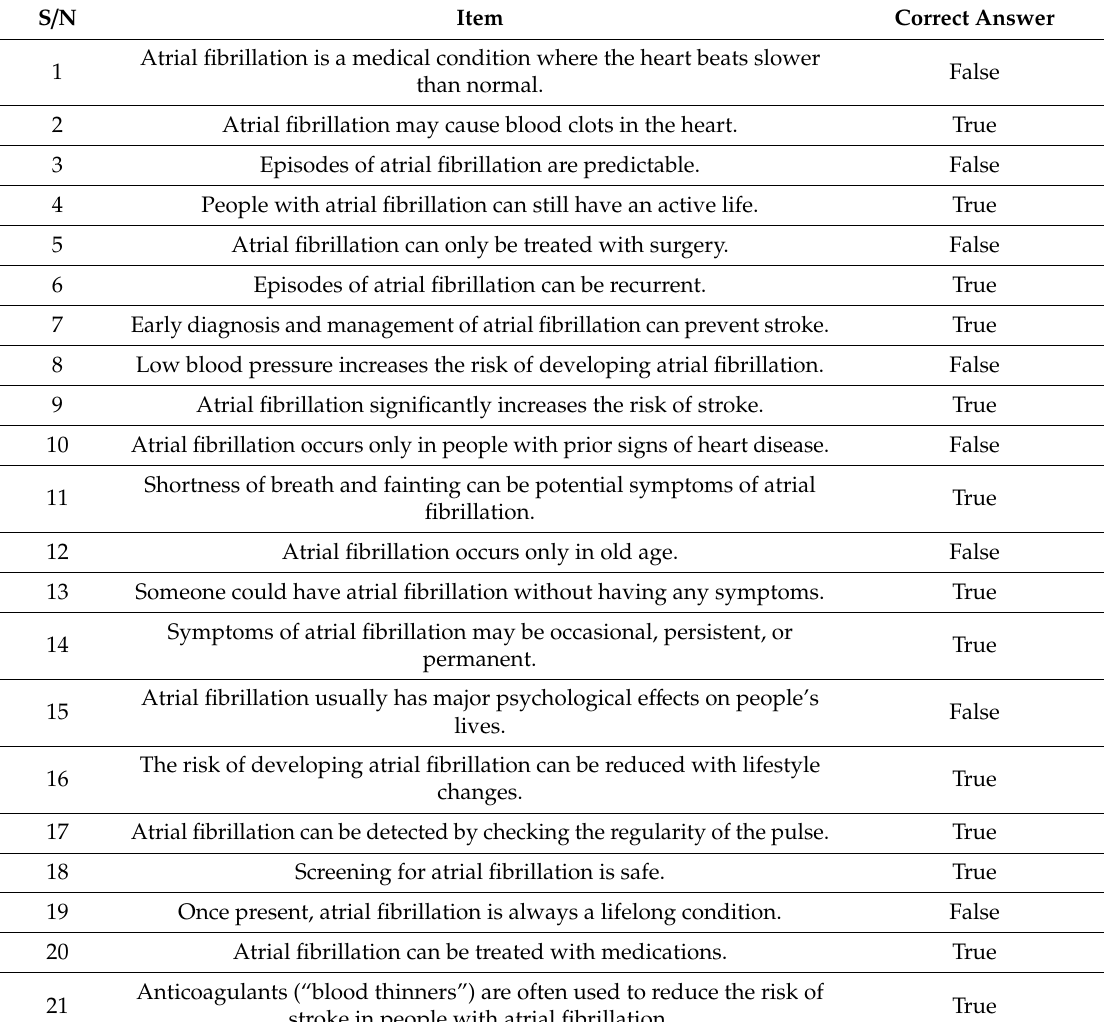
Table 1. AF knowledge assessment tool